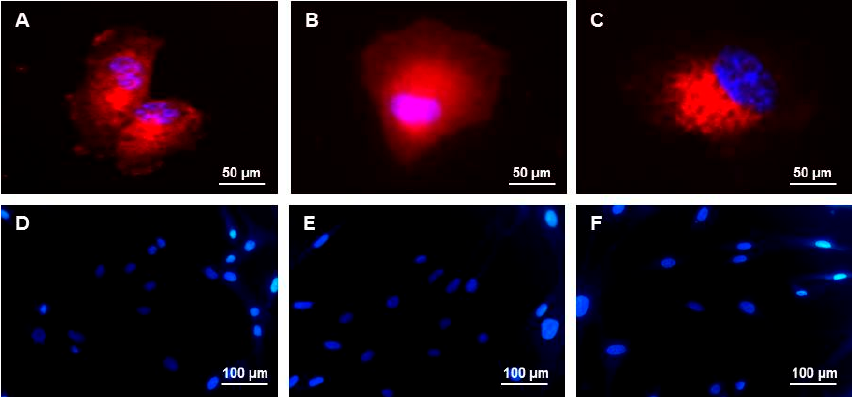
Figure 1. Immunofluorescence staining in human mesenchymal stem cells (hMSCs) at passage three. hMSCs were positive (red) for the stemness markers: ( A ) CD73; ( B ) CD90; and ( C ) CD105. hMSCs were negative for ( D ) fibroblast; ( E ) CD34, and ( F ) CD31 Cell nuclei (blue) were stained with Hoechst 33342.